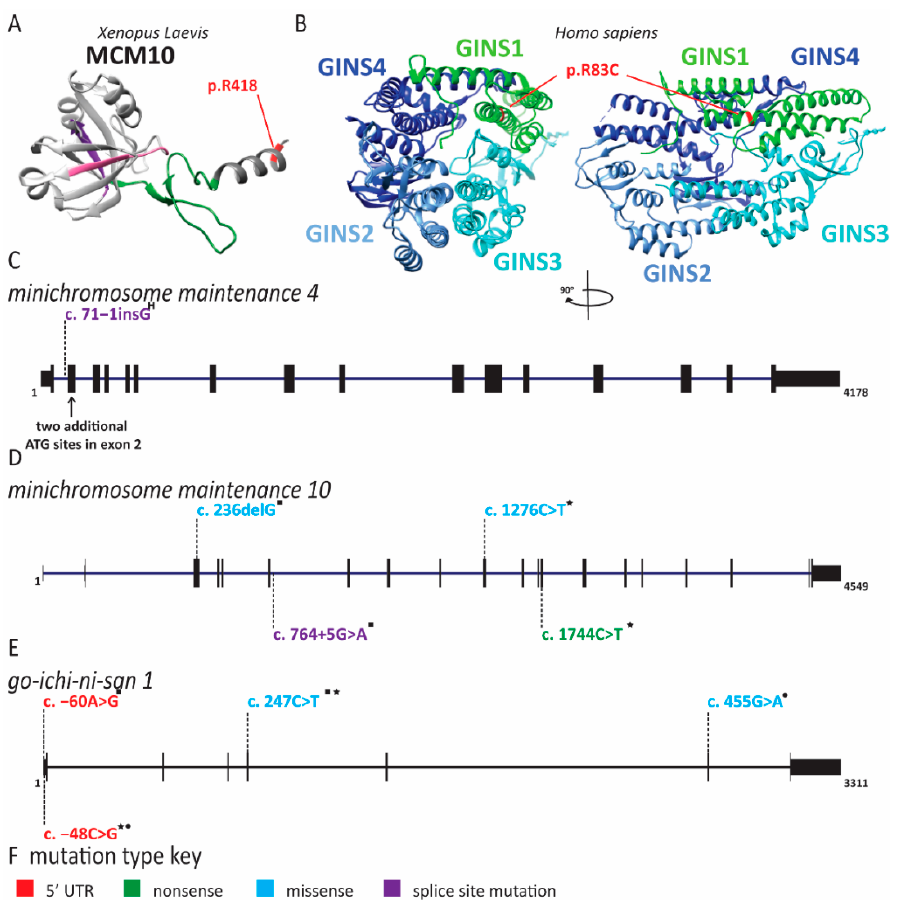
Figure 7. Natural killer cell deficiency is caused by pathogenic variants disrupting DNA replication initiation. Pathogenic mutations in replication initiation factors are depicted on a schematic of each gene and the crystal structure of either Homo sapiens or Xenopus laevis proteins. Mutations that do not have corresponding amino acids in the structure or resulted in abnormal splicing are not depicted. For a complete list of mutations and associated protein changes, see Supplementary Table S1. Structures were generated with the Chimera program (http://www.cgl.ucsf.edu/chimera). Exon and intron schematics were generated with the UCSD genome browser. Reference sequences are MCM4 NM_005914.4, MCM10 NM_018518.5 and GINS1 NM_021067.5. ( A ) Alignment of Homo sapiens and Xenopus laevis MCM10 was completed using UniProt alignment tool (https://www. uniprot.org/align/). Crystal structure of the internal domain of Xenopus laevis MCM10 is shown with PCNA binding peptide box in pink, heat shock protein 10 like domain in purple, and the first zinc finger in green. The Xenopus laevis amino acid corresponding to missense mutation p.R426C (c.1276C > T) is depicted in red. The structure was generated using pdb file 3ebe. ( B ) Missense mutation p.R83C (c.247C > T) in GINS1 is identified in red on the crystal structure of GINS complex. The structure was generated using pdb file 2q9q. Schematic of ( C ) MCM4 , ( D ) MCM10 and ( E ) GINS1 genes depicted with exons as black boxes and introns as horizontal lines. Mutations are mapped to the appropriate gene regions. For MCM4 , two additional ATG sites that result in shorter isoforms occur in exon 2. “H” superscript indicates a homozygous mutation. Compound heterozygous mutation pairs are indicated by superscript symbols. Each mutation combination is depicted, and certain alleles may be present in multiple combinations. The frequency of each allele in the affected population is not indicated. ( F ) For each gene, the color of the mutations indicates the type of mutation according to this